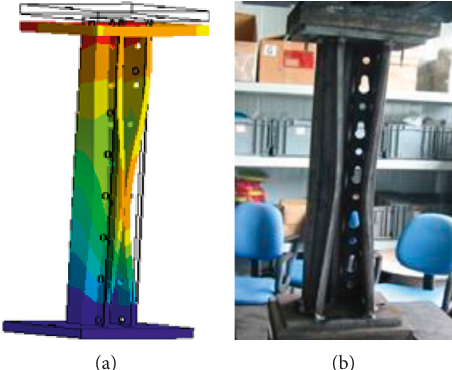
Figure 10: The comparison between FEM simulation and physical test (M90 column).